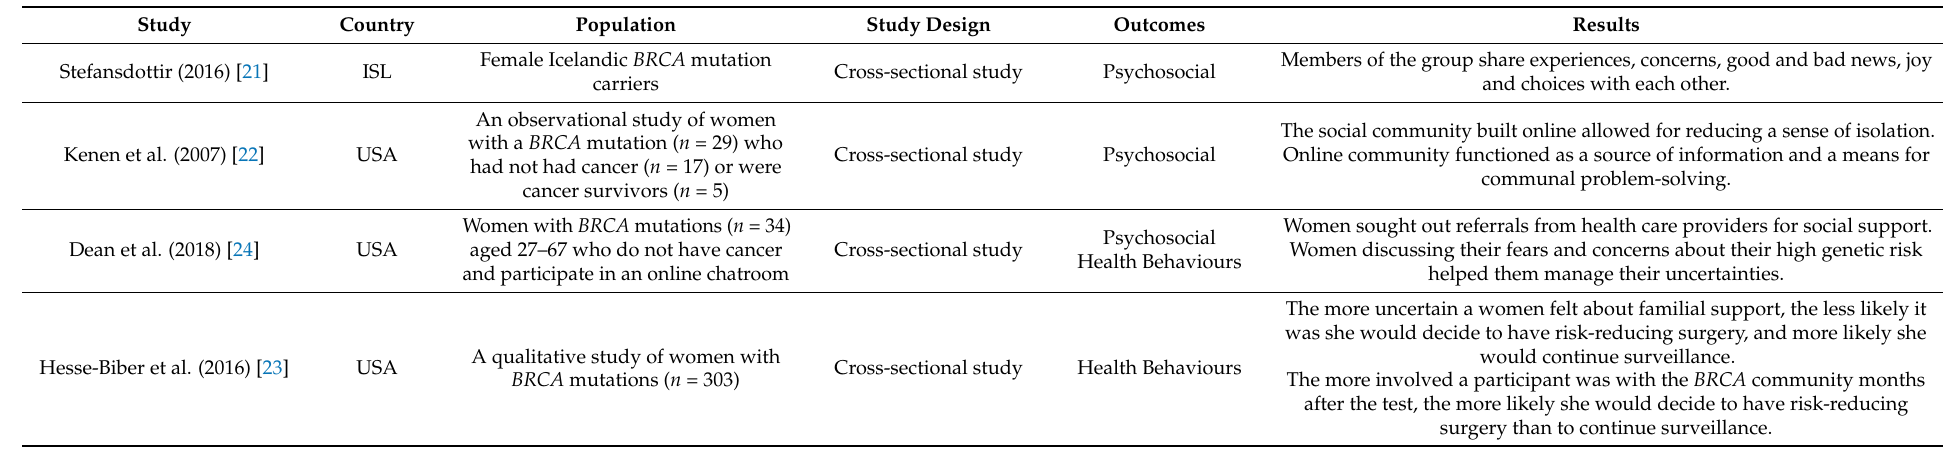
Table 2. Web-Based Intervention.